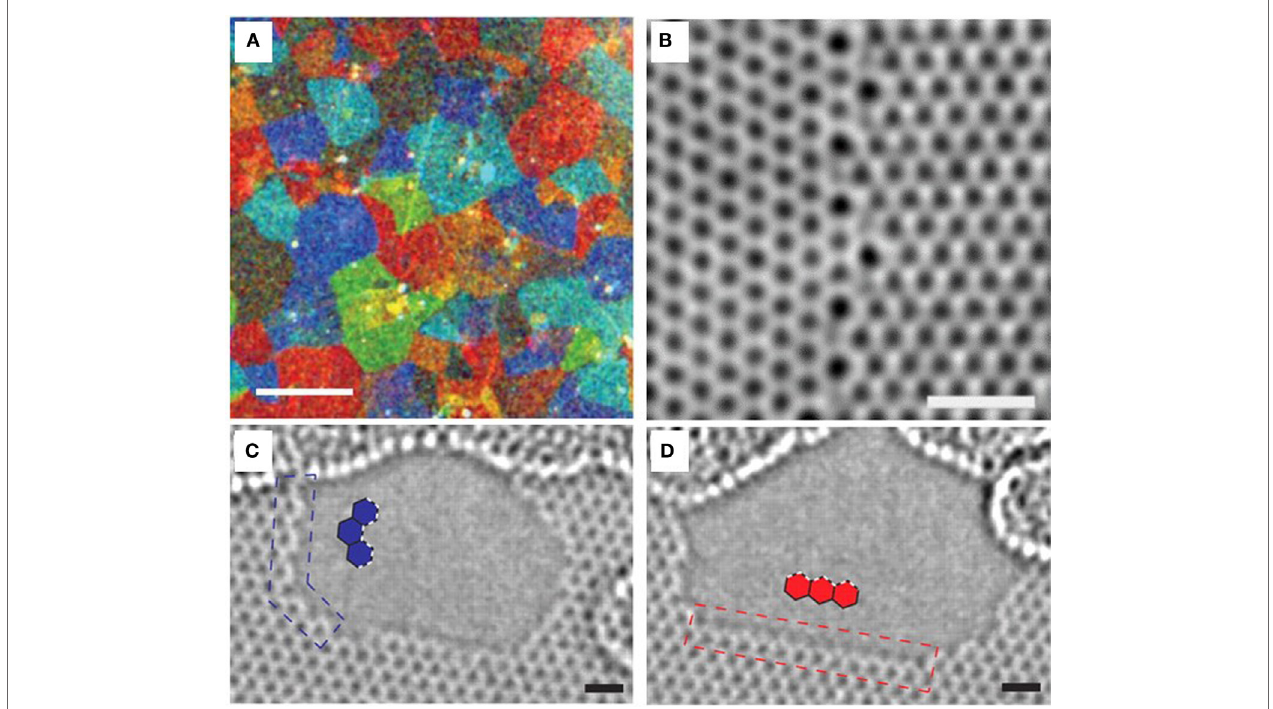
FiGURe 4 | Common defects in graphene sheets . (A) CVD-grown graphene false-color DF-TEM image; it shows grain boundaries in one graphene sheet; (Lee et al., 2013b) Copyright AAAS, 2013. (B) Aberration-corrected TEM image showing the atomic structure of graphene boundary; (Rasool et al., 2013) Copyright Nature Publication Group, 2013. (C,D) Aberration-corrected TEM images of holes on graphene sheet. (C) is armchair boundary and (D) is zigzag boundary (Girit et al., 2009). Copyright AAAS, 2009. Scale bars: (A) 3 μ m; (B) 0.8 nm; (C,D) 0.5